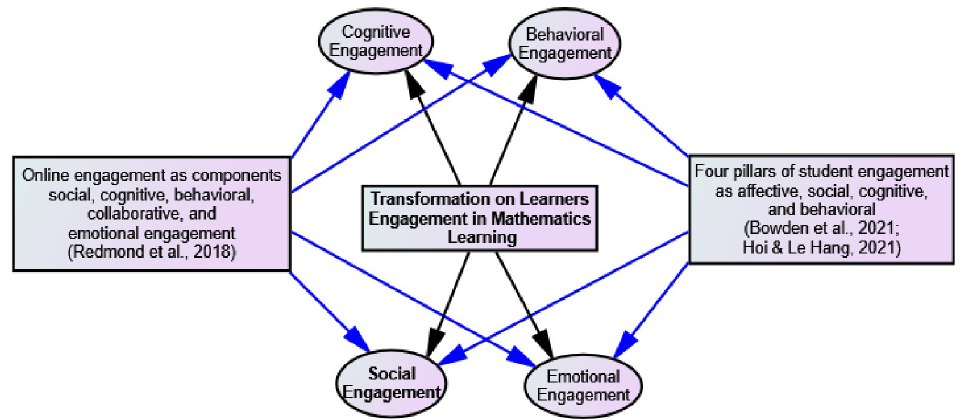
Fig 1. Theoretical framework of learner engagement in terms of social, behavioral, cognitive and emotional engagement (black arrow represents the domain of research and blue arrow represents the support connection of